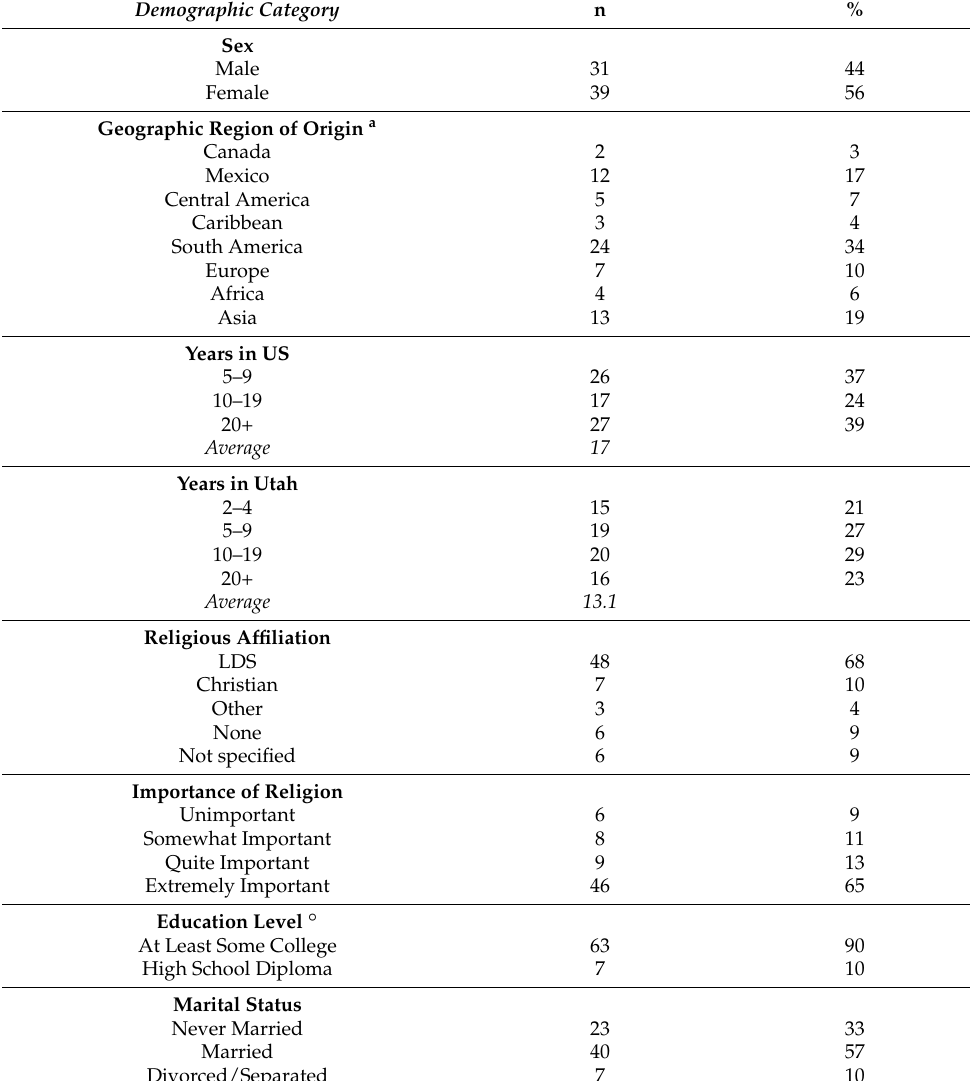
Table 1. Summary of interviewee demographic